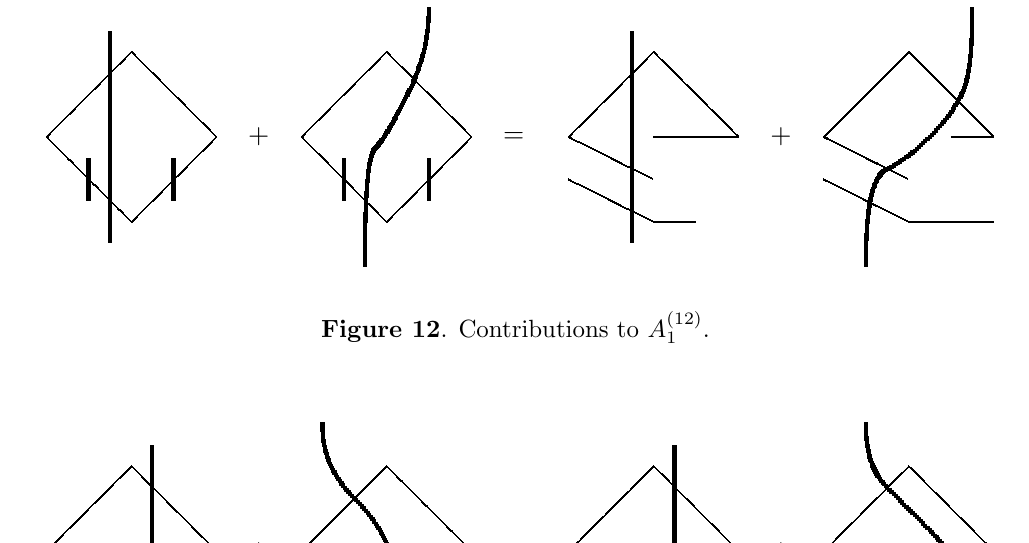
Figure 13 . Contributions to A (12)